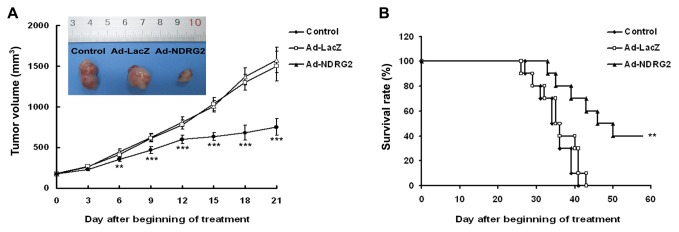
Effects of Ad-NDRG2 intratumoral injections on tumor growth and long-term survival of 786-O cells tumor-bearing mice.(A) Tumor growth curve. The tumor growth was assessed every 3 days until Day 21 of treatment by measuring two perpendicular diameters and calculating the volume in mm3. Statistical analysis was assessed with one-way ANOVA. ** or *** indicates P < 0.01 or P < 0.001 when compared with the Ad-LacZ group. (B) Kaplan–Meier curve was shown in the Control, Ad-LacZ and Ad-NDRG2 groups, with each group consisting of ten mice. There was a significant difference between Ad-NDRG2 and Ad-LacZ treatments. Statistical significance was assessed using log-rank tests. ** indicates P < 0.01 when compared with the Ad-LacZ group.